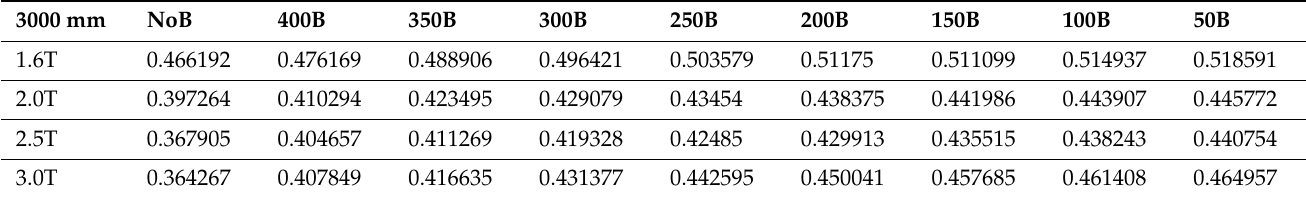
Table 2. Ultimate normalised compressive capacities for 3000 mm models based on reinforcement